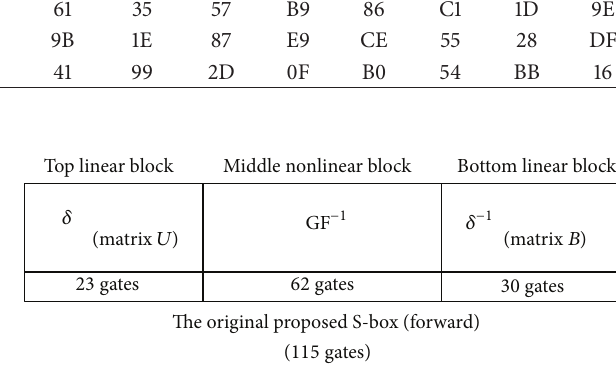
Figure 2: The illustration of Boyar’s minimized